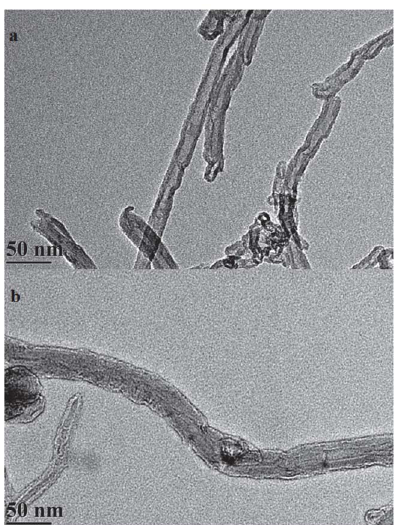
Figure 3. TEM images of functionalised MWNT (a) and MWNT bound lipase (b).